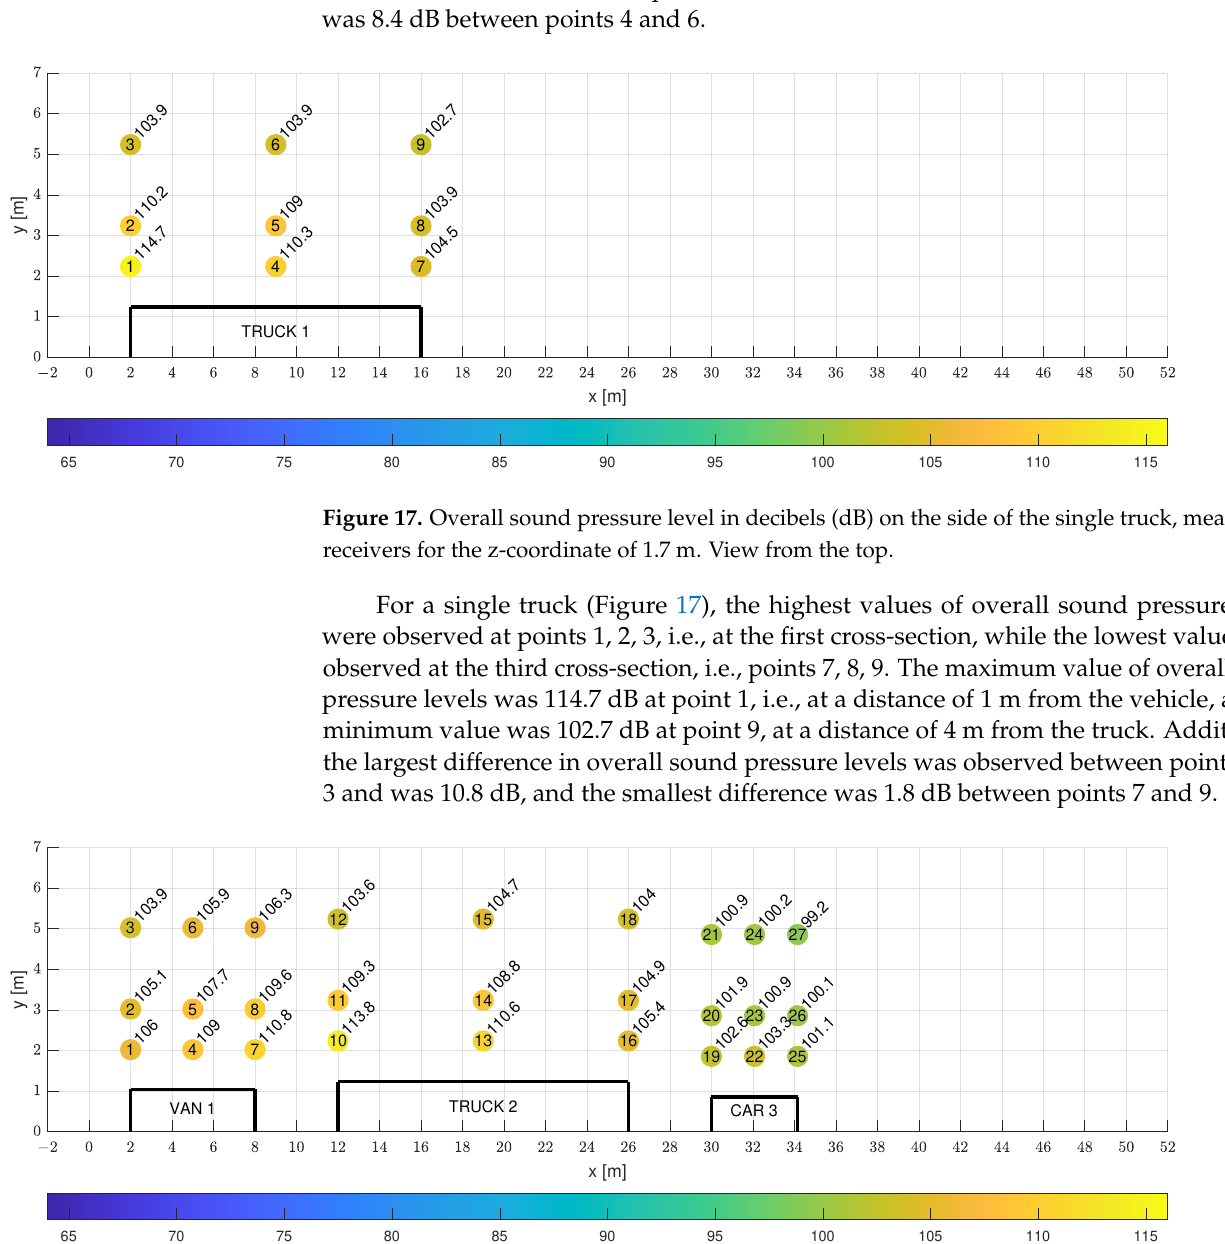
of 1 m from the vehicle, and the minimum value was 66.1 dB at point 3, at a distance of 4 m from the passenger car. Additionally, the largest difference in overall sound pressure levels was observed between points 7 and 9 and was 13.8 dB, and the smallest difference was 8.4 dB between points 4 and 6.